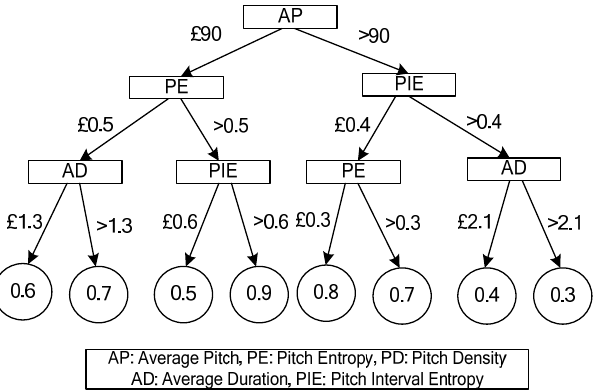
Figure 6. An example of a user’s refreshing music decision